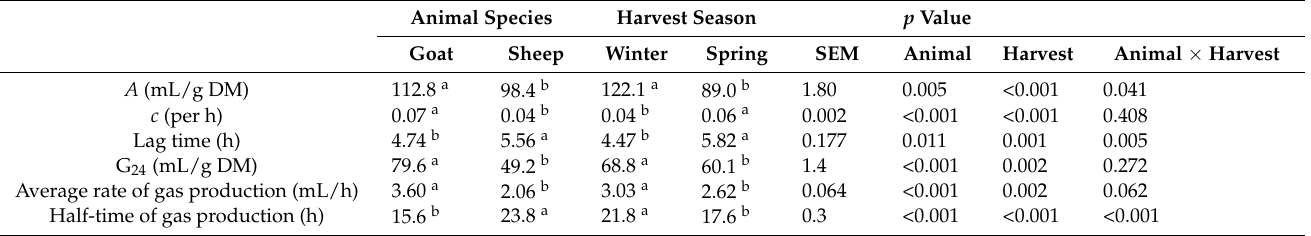
Table 3. Kinetics of in vitro gas production of Paulownia shan tong harvested in winter and spring and incubated with rumen liquor from goats or